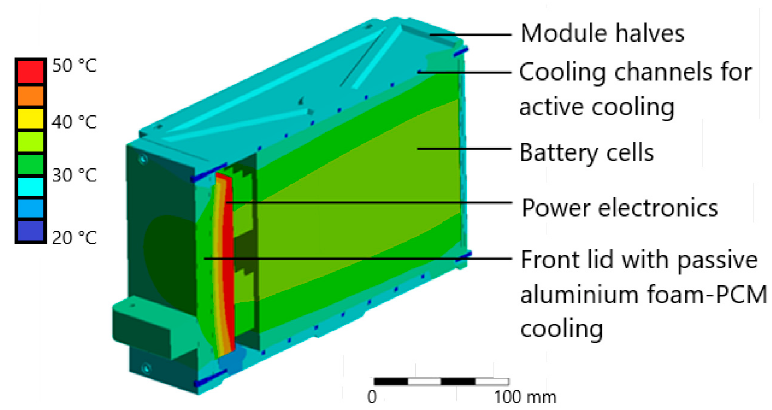
Figure 5. Sectional view of temperature distribution within the module.